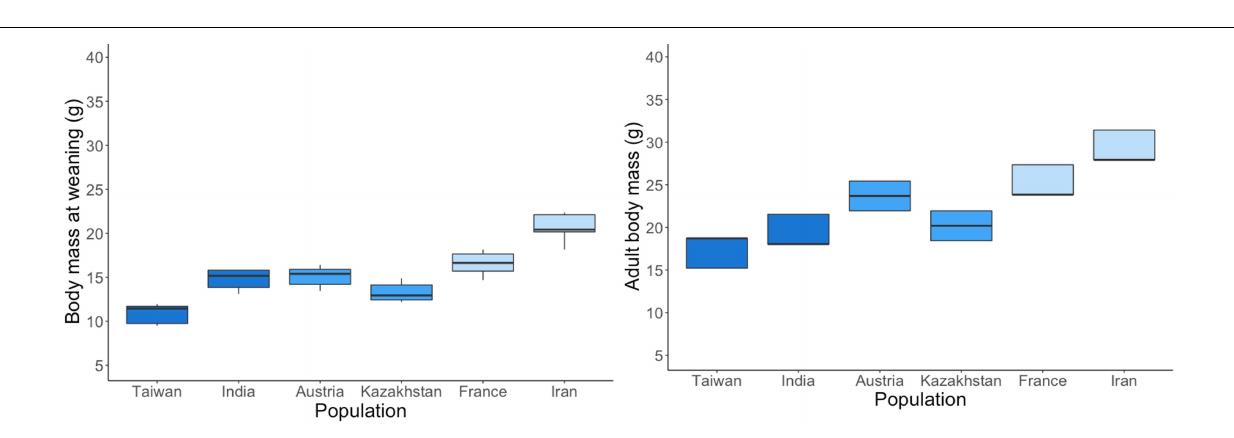
FIGURE 4 | Body mass at weaning (28–30 days) and adulthood (6–12 months). The two populations per subspecies are shown in the same shade of